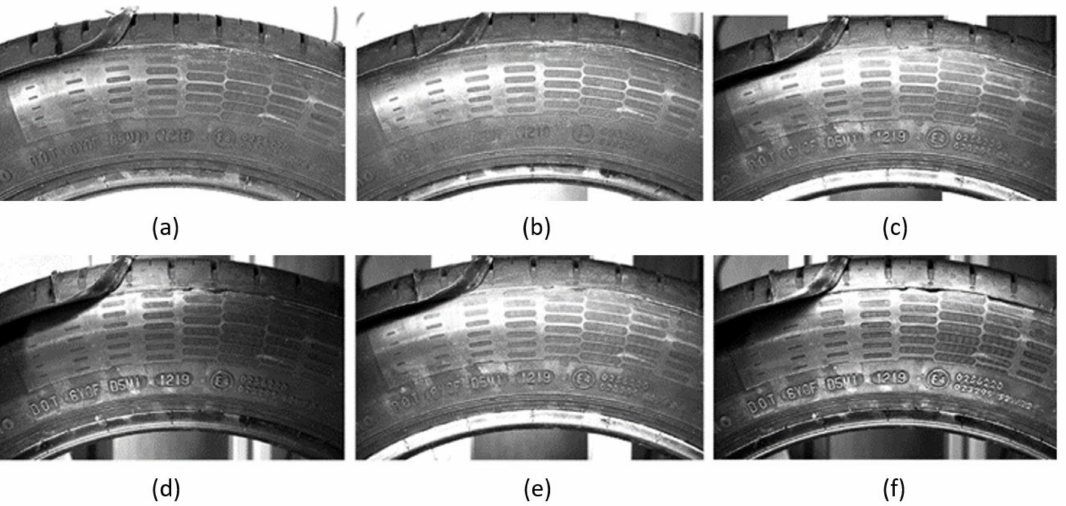
Figure 7. Visualizations variations of used different types of lights. (( a ) without lighting, ( b ) circular light, ( c ) two line white 100 mm lights, ( d ) two IR line 100 mm lights, ( e ) two red line 200 mm lights, ( f ) two red line 200 mm lights at an angle of 30 ◦